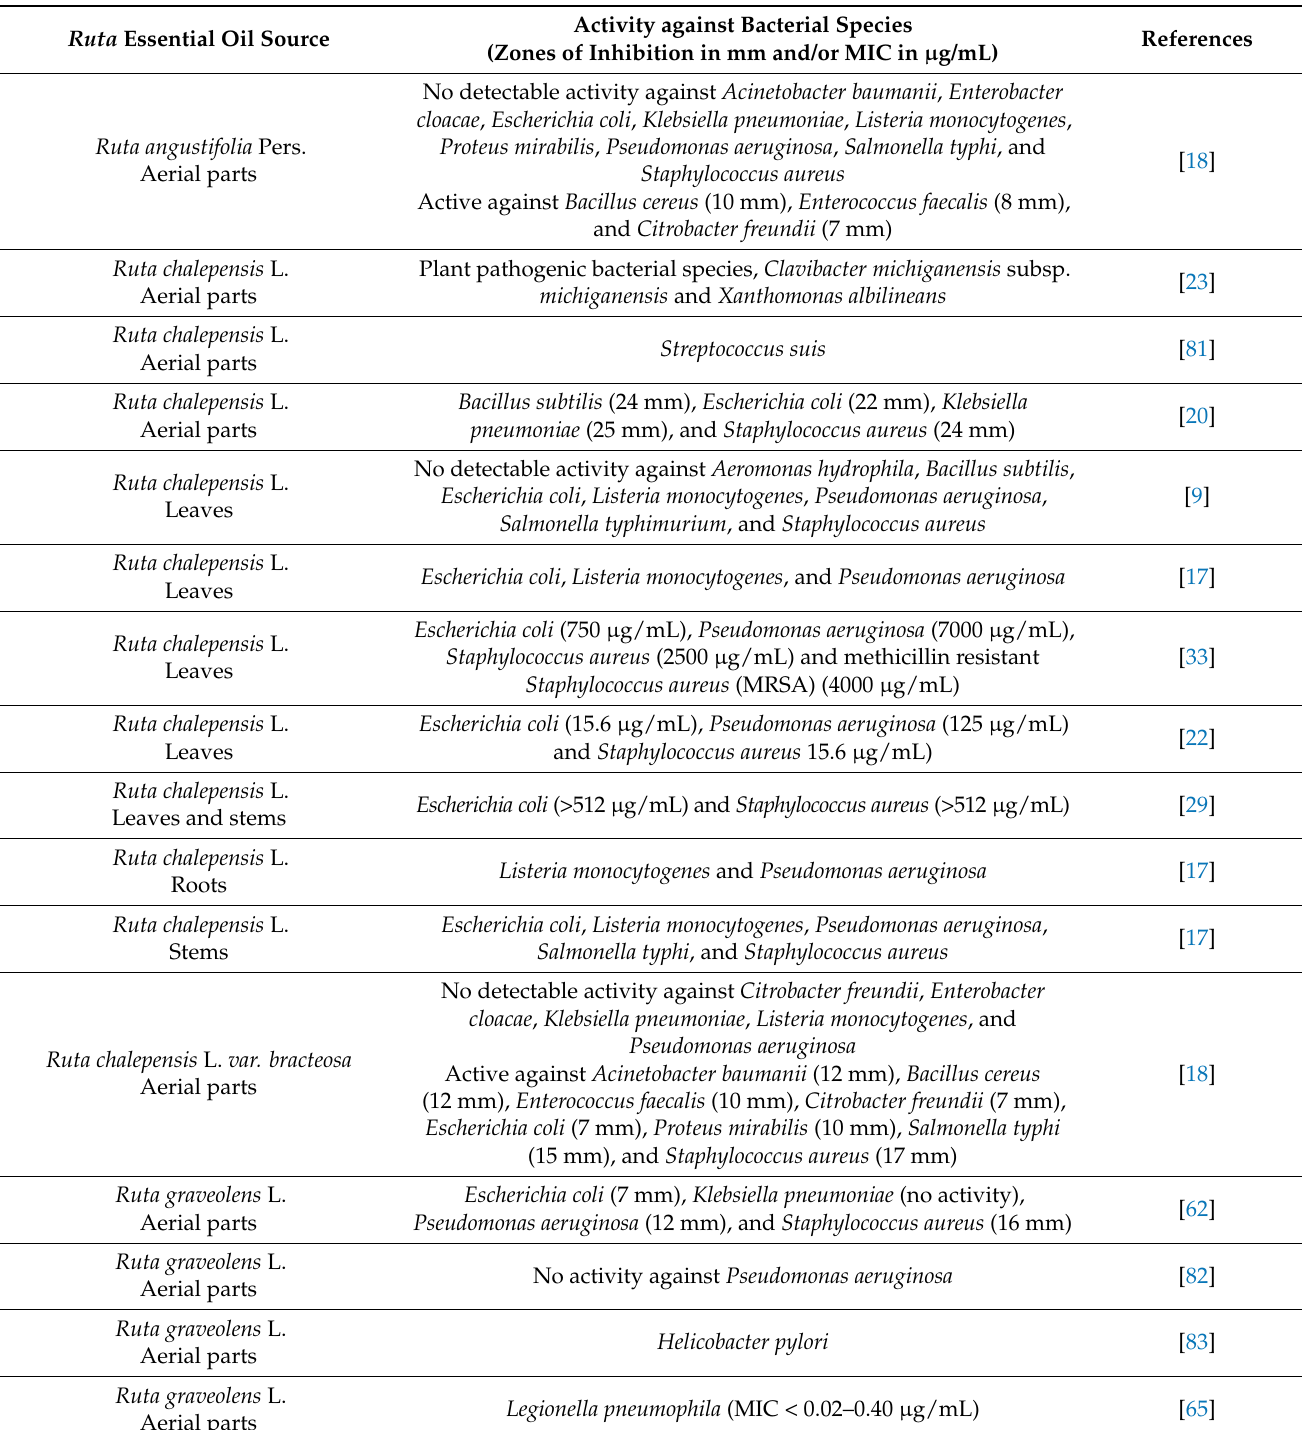
Table 2. Antibacterial activity of Ruta essential